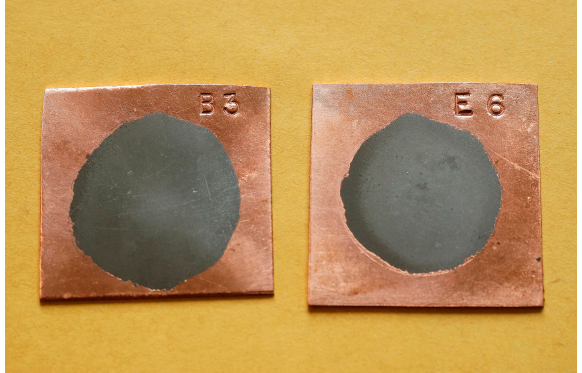
Figure 2 . Hydrogen oven and H 2 generator.